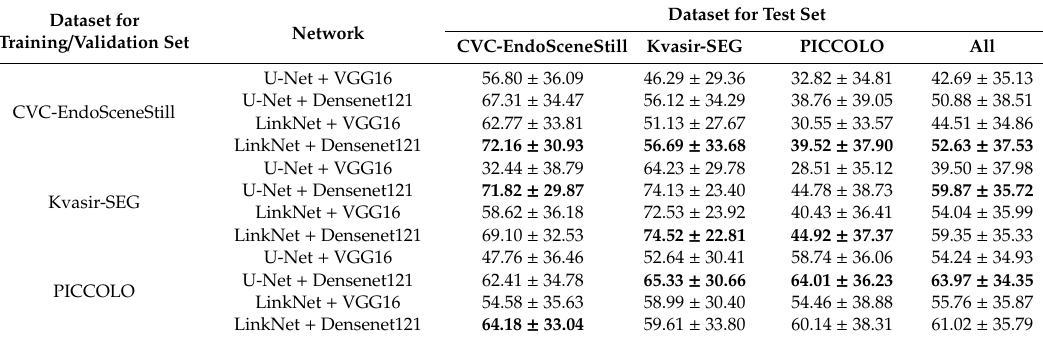
Table 4. Jaccard index for each experiment. Best value per train / validation set and test set is indicated in